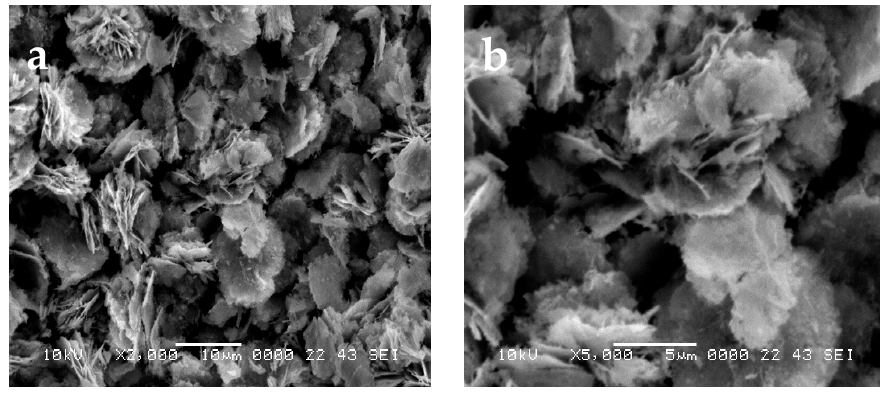
Figure 2. SEM images of Px-CuO NSs ( a ) with low magnification, ( b ) with high magnification.